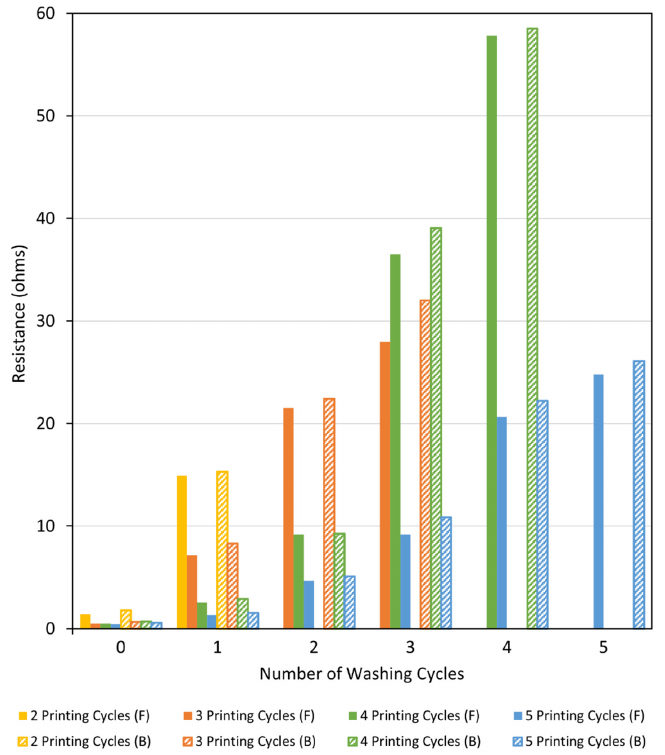
Figure 14. Resistance of the face (F) and back (B) side of the metallised samples printed with the Cu–Ag NP catalyst at different numbers of cycles in the weft direction versus number of washing cycles. Table 1. Colour fastness of the metallised textiles printed with the Cu–Ag NP catalyst at different numbers of printing cycles and directions. No. of Printing Cy-